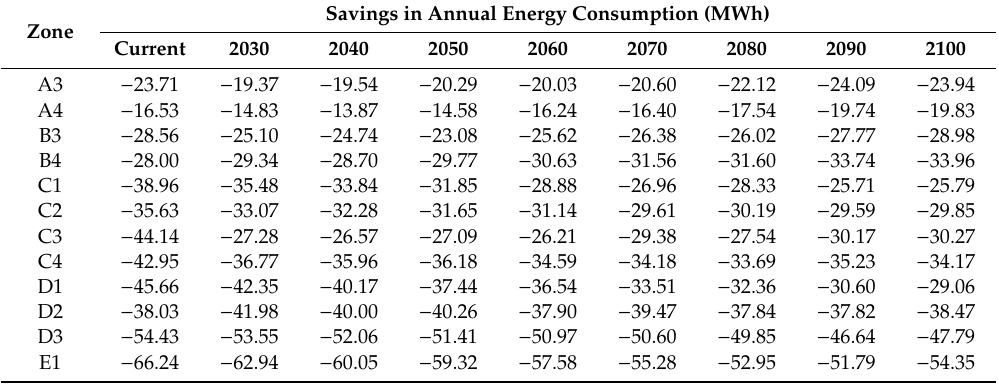
Table 7. Energy savings obtained with the plasterboard considering an operational pattern based on